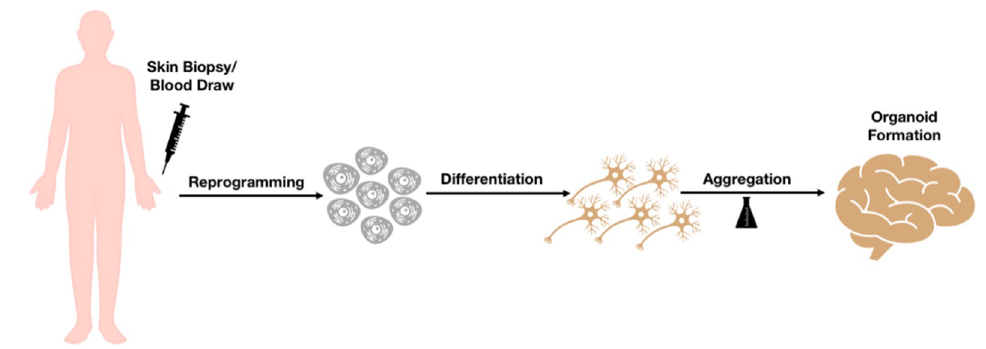
Figure 2. Workflow of human organoids obtainment. Patients’ derived cells (fibroblasts or peripheral blood mononuclear cells) are reprogrammed to iPSCs, which are then differentiated to neural precursors. These are directed towards the formation of aggregates (typically with the use of spinning bioreactors) which are then organized into a cerebral organoid structure.